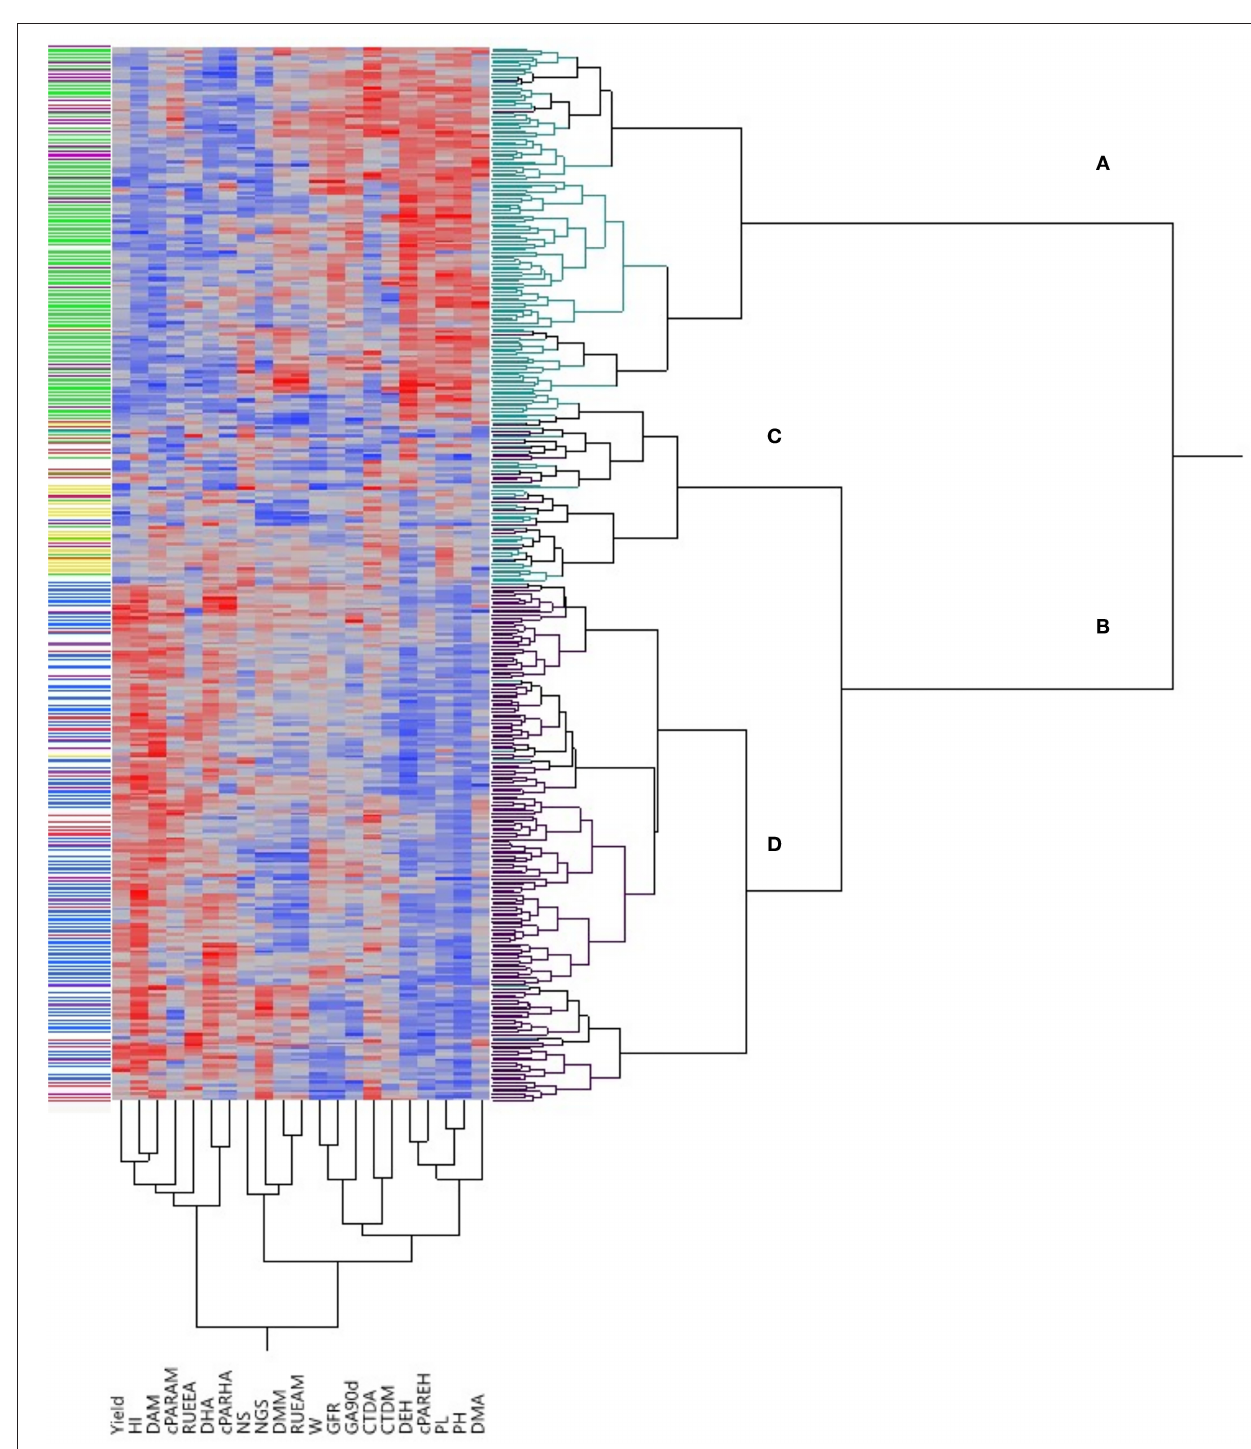
FIGURE 1 | Bi-dimensional clustering showing the relationships between the 372 genotypes included in this study according to the traits shown in the bottom part of the figure. Red and blue colors in the columns denote high and low values, respectively, for each trait, with color intensity associated to trait values. Green and black cluster lines at right correspond to landraces and modern cultivars, respectively. Cluster lines at left indicate genetic subpopulations: yellow, SP1; green, SP2; purple, SP3; blue, SP4; red, SP5; white, admixed. NS, number of spikes/m 2 ; NGS, number of grains/spike; W, grain weight; HI, harvest index; DEH, days from emergence to heading; DHA, days from heading to anthesis; DAM, days from anthesis to maturity; GFR, grain filling rate; PL, peduncle length; PH, plant height; DM A , dry matter at